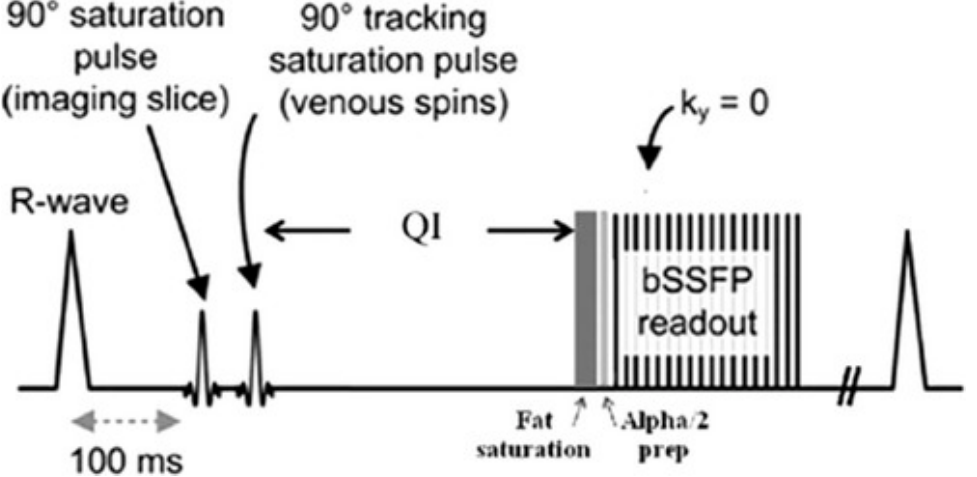
Figure 1. Depiction of pulse sequences in QISS MRA. Reproduced with permission from [21]. ms: millisecond; QI: Quiescent interval.